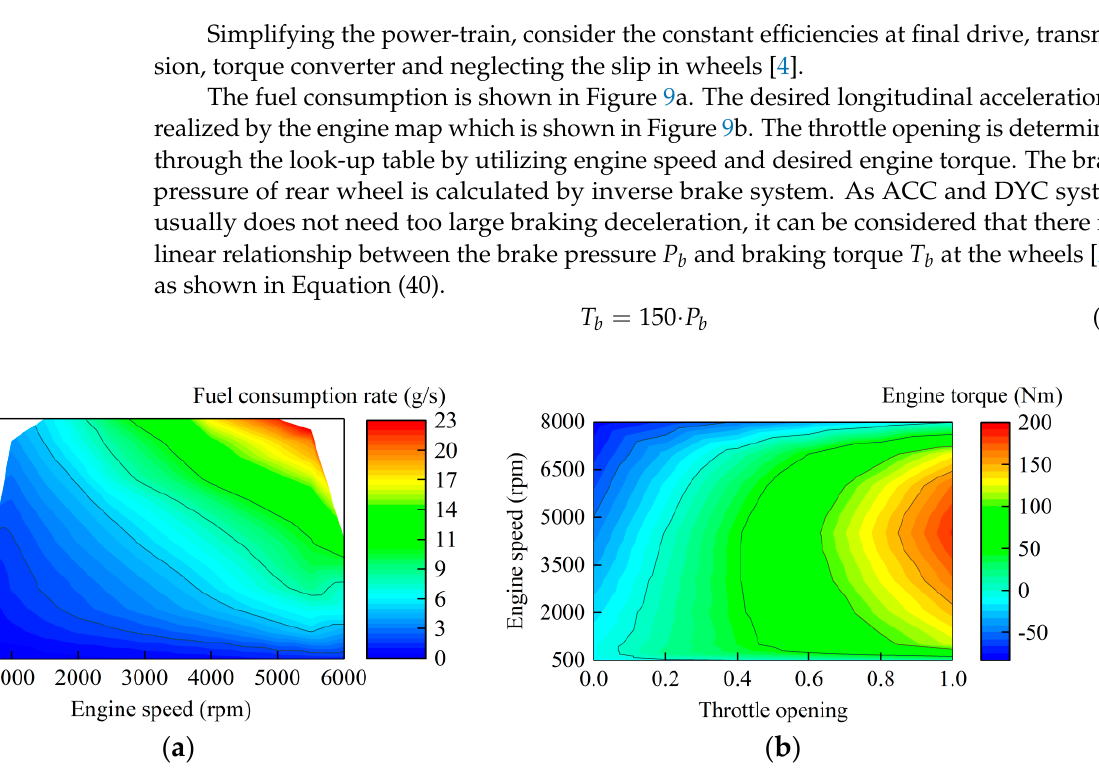
Figure 9. Fuel consumption rate and map of engine: ( a ) fuel consumption rate of engine; ( b ) engine map. The relationship between F d and engine output torque T e is as follows